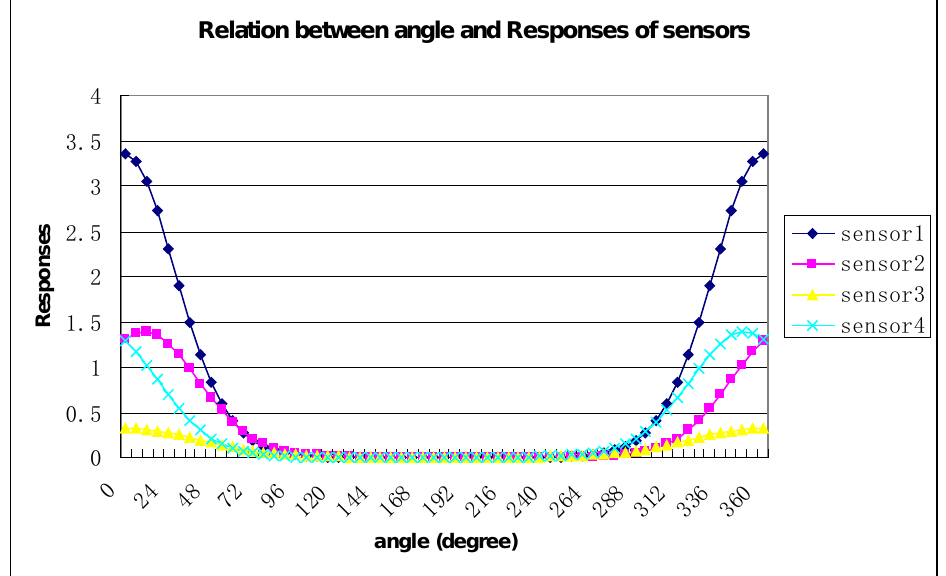
Figure 2 . Simulated series of stable sensors responses in advection case for different source directions θ